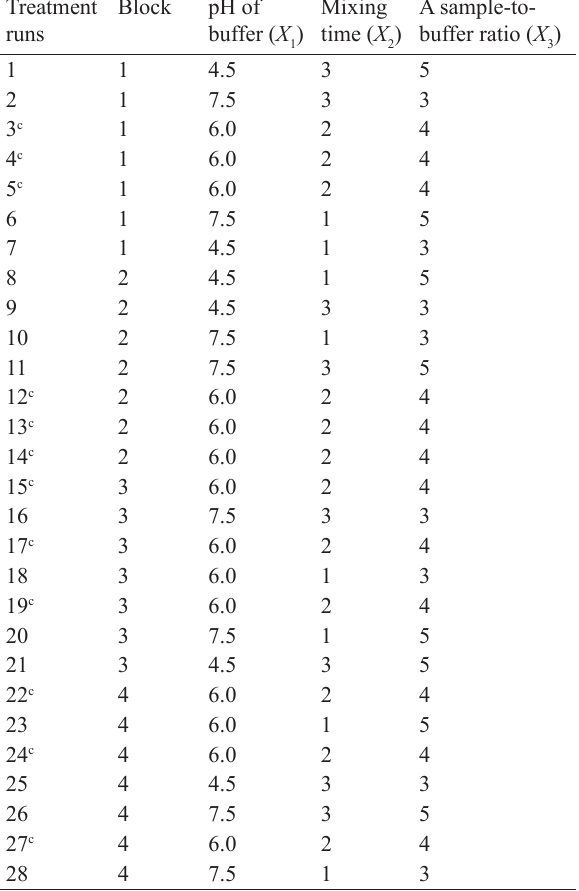
Table 1 The matrix of full factorial design Treatment